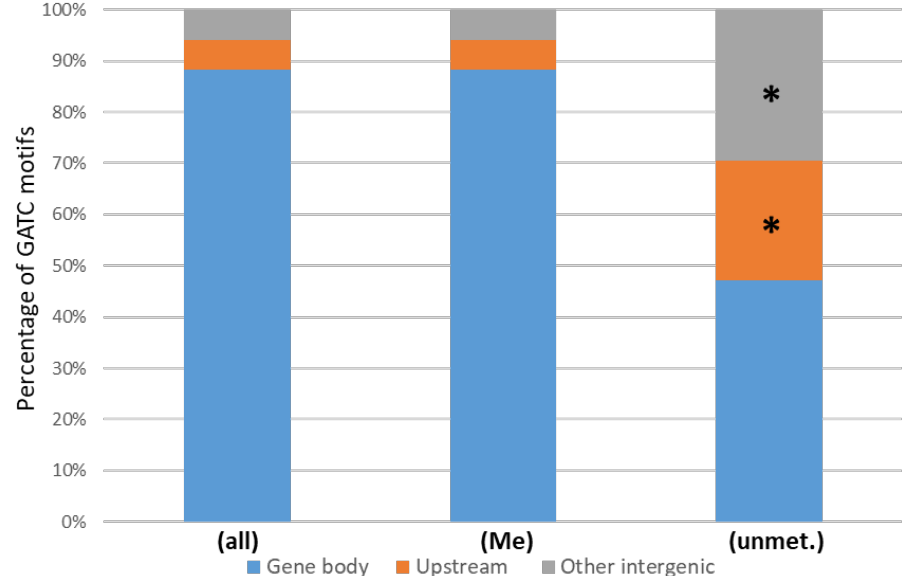
Figure 4. Location of unmethylated GATC motifs . Proportion of GATC motifs located in gene body (blue), in putative promoter (i.e., <100 bp upstream from a start codon) (orange), or in intergenic region (grey). (all), all motifs found in the genome; (Me), methylated motifs; (unmet.), unmethylated motifs. Asterisks indicate that the proportion of motifs located in upstream region vs. gene body is significantly different from the proportion observed in the (all) condition ( p < 0.01, Fisher’s exact test).